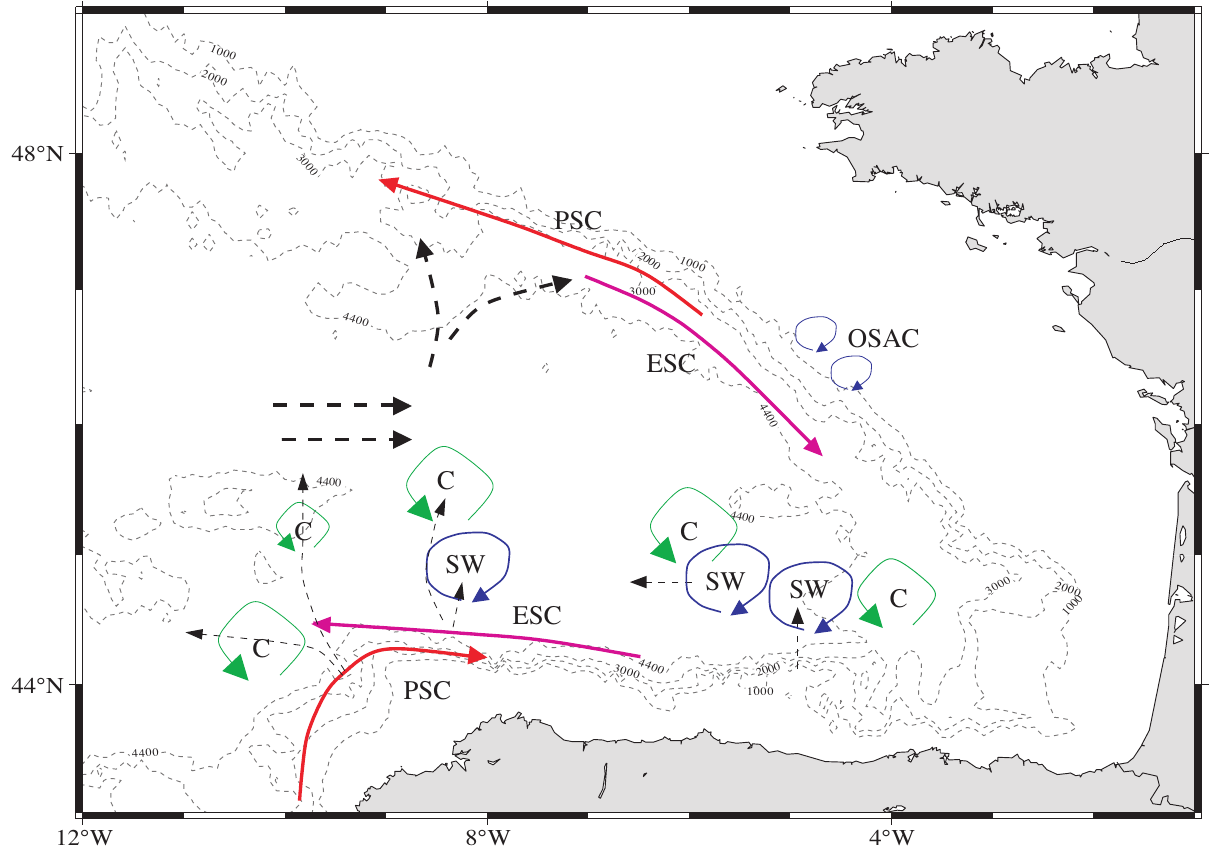
F IG . 10. – Summary sketch of the observed mesoscale features. Abbreviations are: PSC (Poleward Slope Current), ESC (Equatorward Slope Current), C (Cyclone), SW (Slope Water anticyclonic eddy) and OSAC (Outer Shelf AntiCyclone). Thin dashed arrows indicate the mean drift of the eddies (if observed). Thick dashed arrows indicate some observed NACW